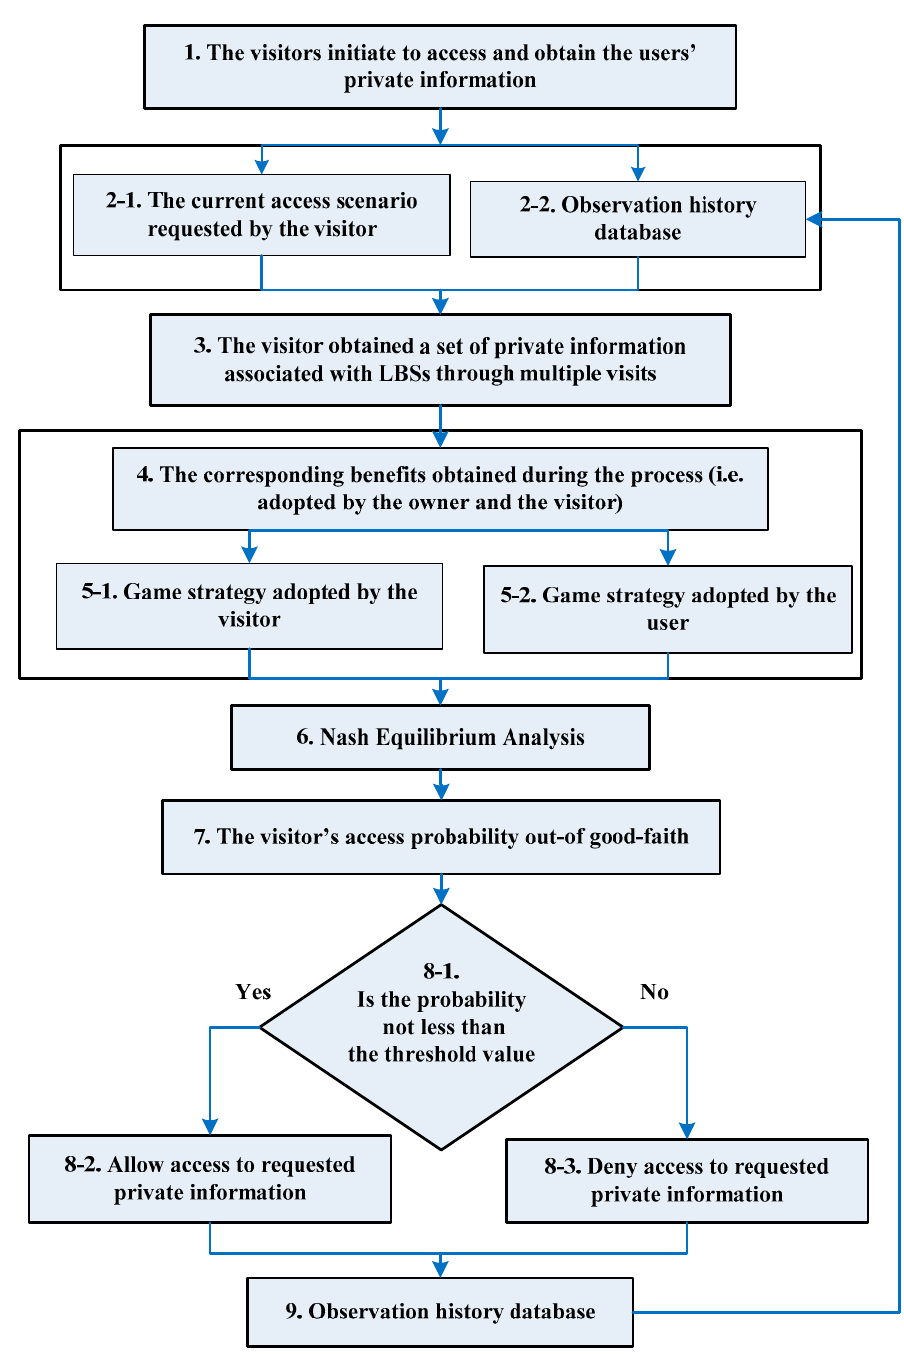
Figure 2. Proposed game-theory privacy protection model.